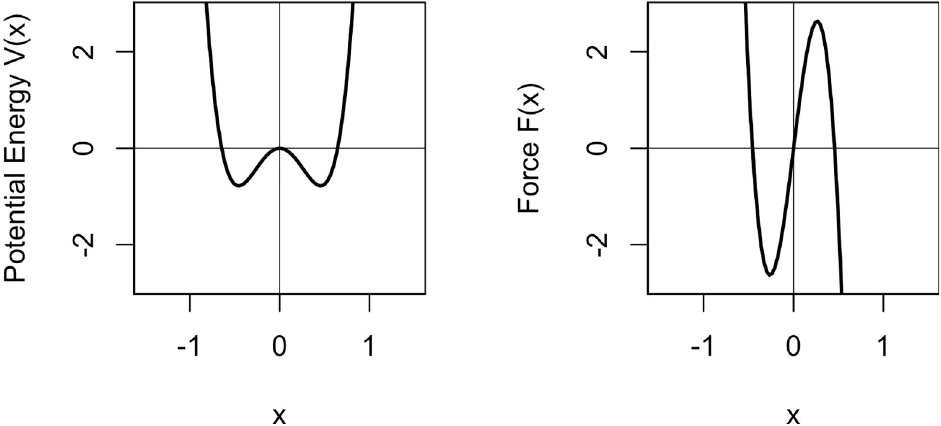
Fig 12. Potential energy function V(x) from (5) and force function F(x) from (6) for k =